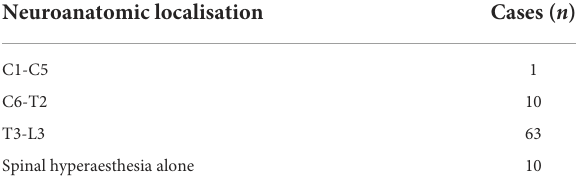
TABLE 3 Frequency of the different neuroanatomic